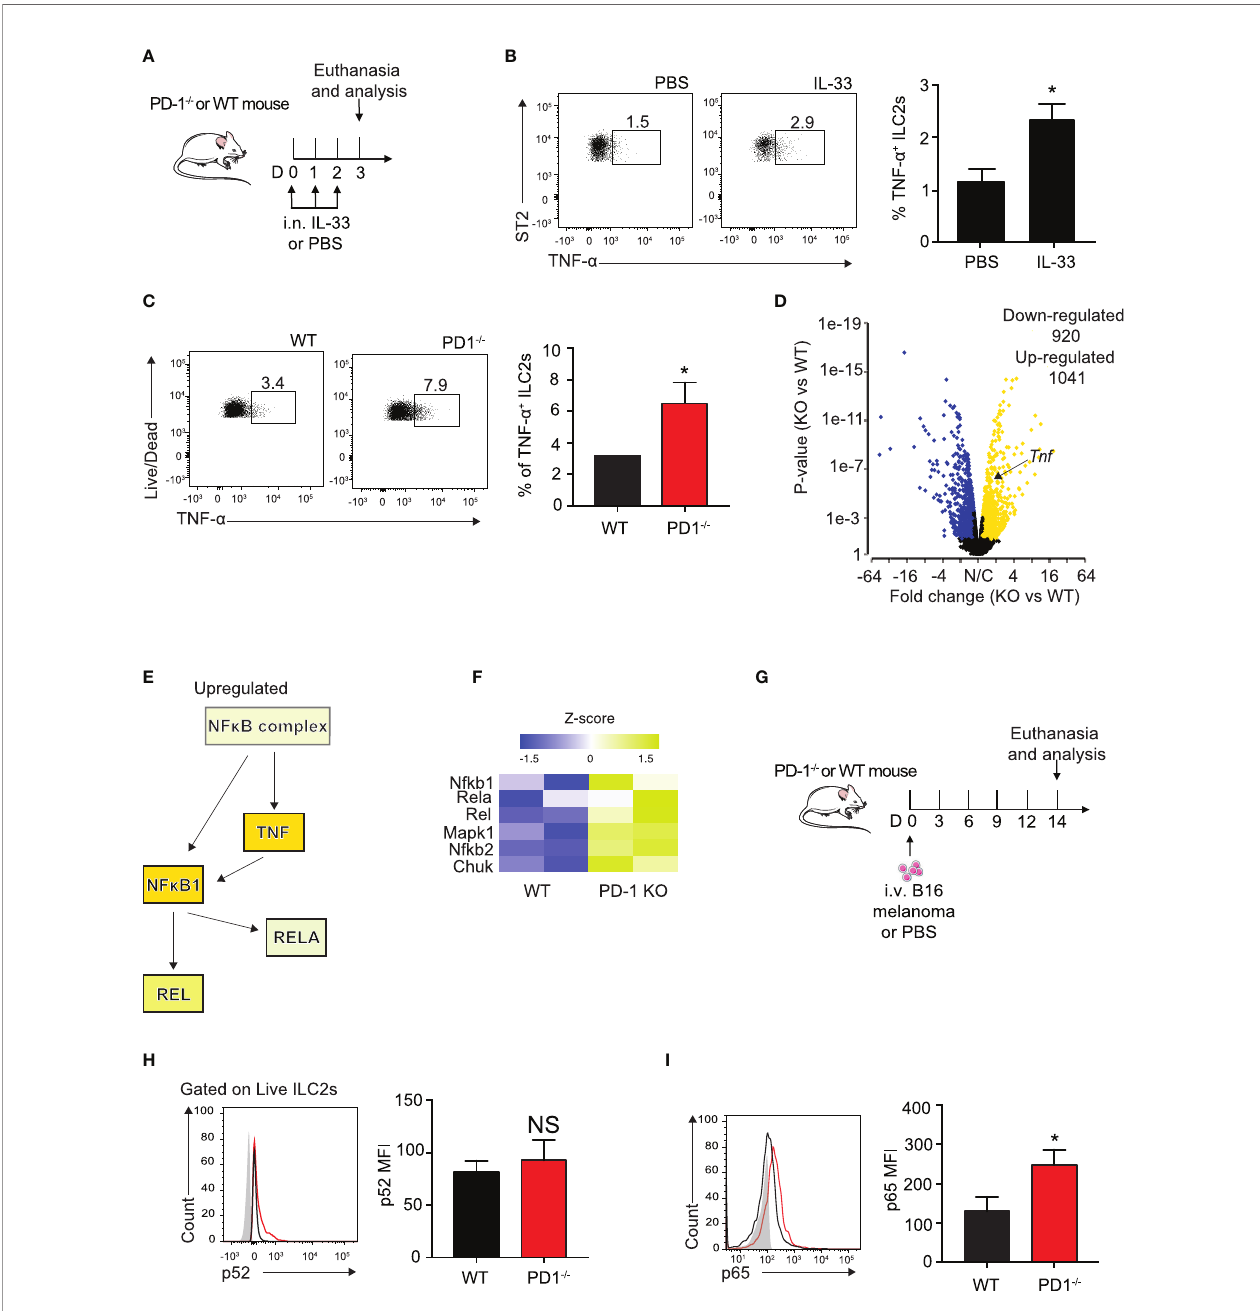
FIGURE 3 | PD-1 de fi ciency on IL-33 stimulated ILC2s enhances TNF-a expression and phosphorylation of canonical NF k B pathway. (A) A cohort of WT mice were intranasally challenged with IL-33 (0.5µg) for three consecutive days, days 0-2. On day 3, mice were euthanized and percentage of TNF- a + ILCs was quanti fi ed in (B) . (C) A cohort of WT or PD-1 -/- mice were intranasally challenged with IL-33 (0.5µg) for three consecutive days, days 0-2. On day 3, mice were euthanized and percentage of TNF- a + ILCs was quanti fi ed. (D) Volcano plot comparison of whole transcriptome gene expression of sorted PD-1 -/- ILC2s and WT control, n=2. Differentially expressed genes (de fi ned as statistically signi fi cant adjusted p-value<0.05) with changes of at least 1.45 fold-change (FC) are shown in yellow (upregulated genes) or blue (downregulated genes). (E) Upregulated (yellow) genes in the NF k B pathway and corresponding heatmap representation (F). (G) A cohort of PD-1 -/- or WT mice was given an intravenous injection of B16 melanoma (2.5 x 10 5 ) on day 0. On day 14, lung ILC2s were identi fi ed as de fi ned in Figure 1C and transcription factors involved in the NF k B pathway were measured for phosphorylation by intranuclear fl ow cytometry. (H) Representative fl ow cytometry plots and corresponding quanti fi cation of phosphorylation levels of transcription factor p52. (I) Representative fl ow cytometry plots and corresponding quanti fi cation of phosphorylation levels of transcription factor p65. Error bars are the mean±SEM. Data are representative of 3 individual experiments with n=5. Student ’ s t-test, NS = Non-statistical, *p <